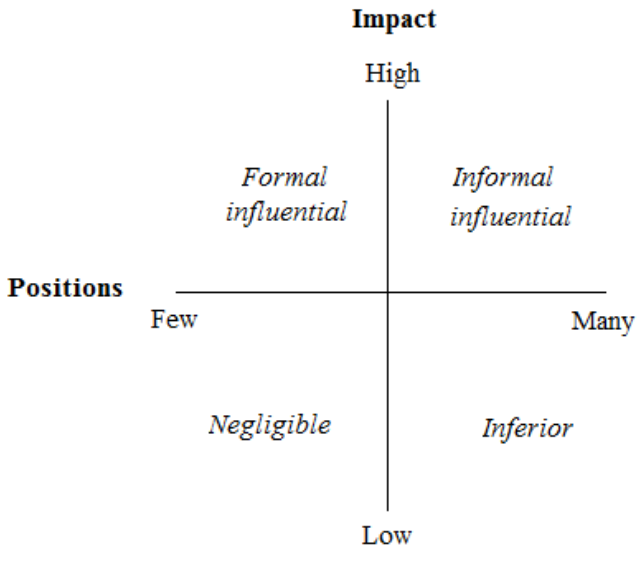
Figure 1. Our analytical approach towards understanding the engagement of pro- fessions in